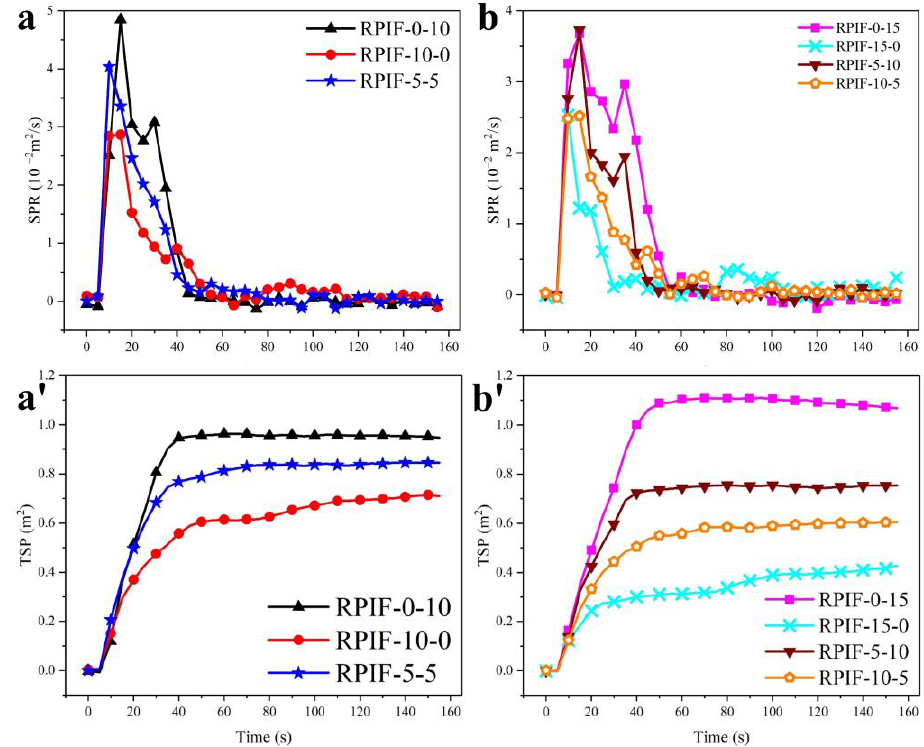
Figure 9. SPR and TSP curves of RPIF with the total dosage of EG and PPCP at 10 wt. % ( a , a (cid:48) ) and 15 wt. % ( b , b (cid:48)